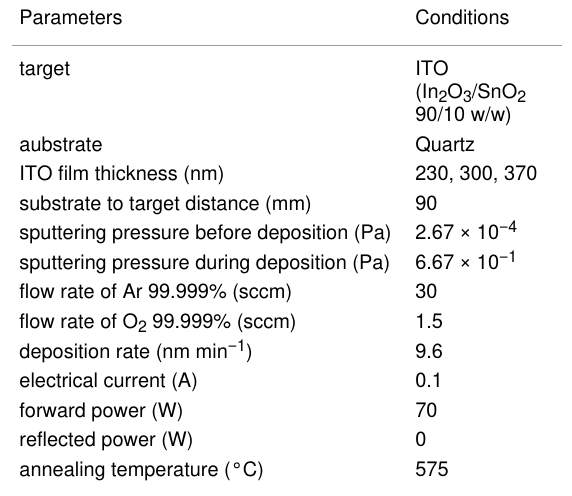
Table 1: Parameters and conditions for the production of ITO thin